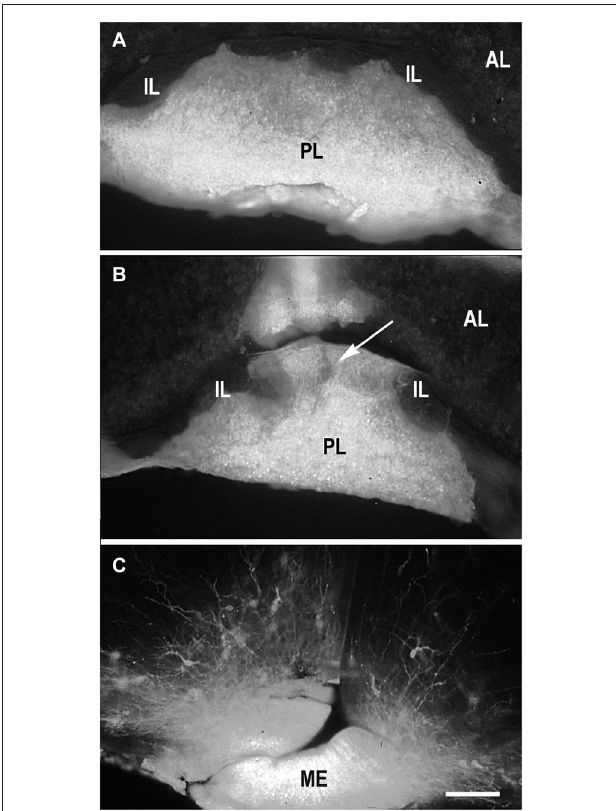
FIGURE 1 | DiI labeling of the posterior lobe of the pituitary and median eminence . DiI distribution in the pituitary after insertion into the posterior pituitary lobe (PL) without damage of the boundary between the PL and intermediate (IL) pituitary lobes (A) . DiI insertion with labeling in the PL and part (arrow) of IL (B) . DiI insertion in the median eminence (ME) with few labeled neurons in the arcuate nucleus (C) . AL – anterior pituitary lobe. Scale bar = 100 µ